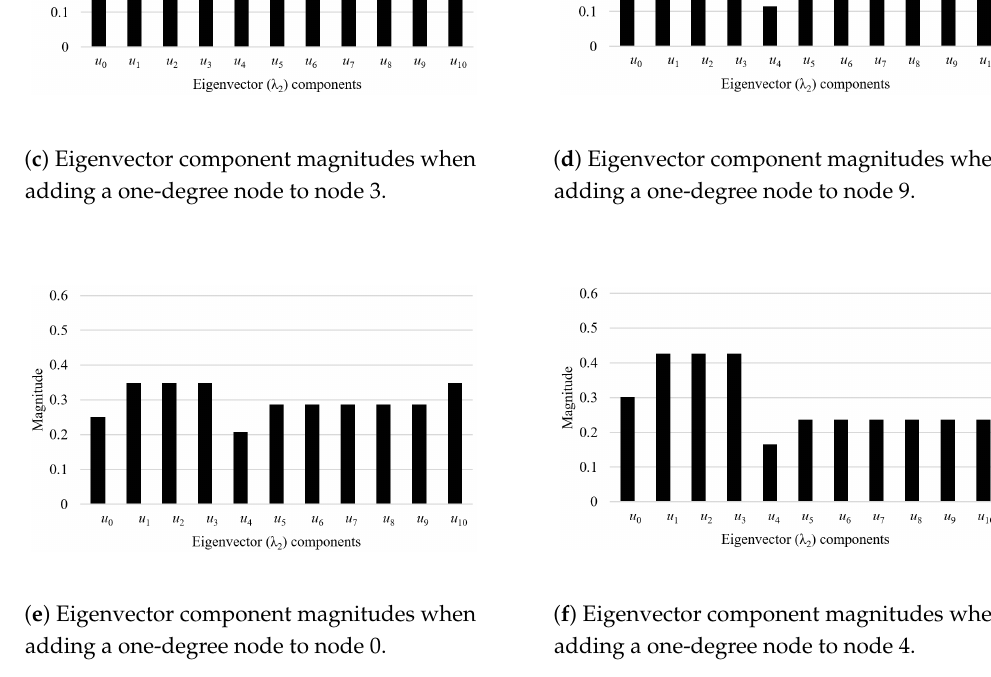
Figure 2. A 10-node network and the spectral analysis plots. Nodes 0 to 9 maps to u 0 to u 9 , with u 10 mapping to the newly-added